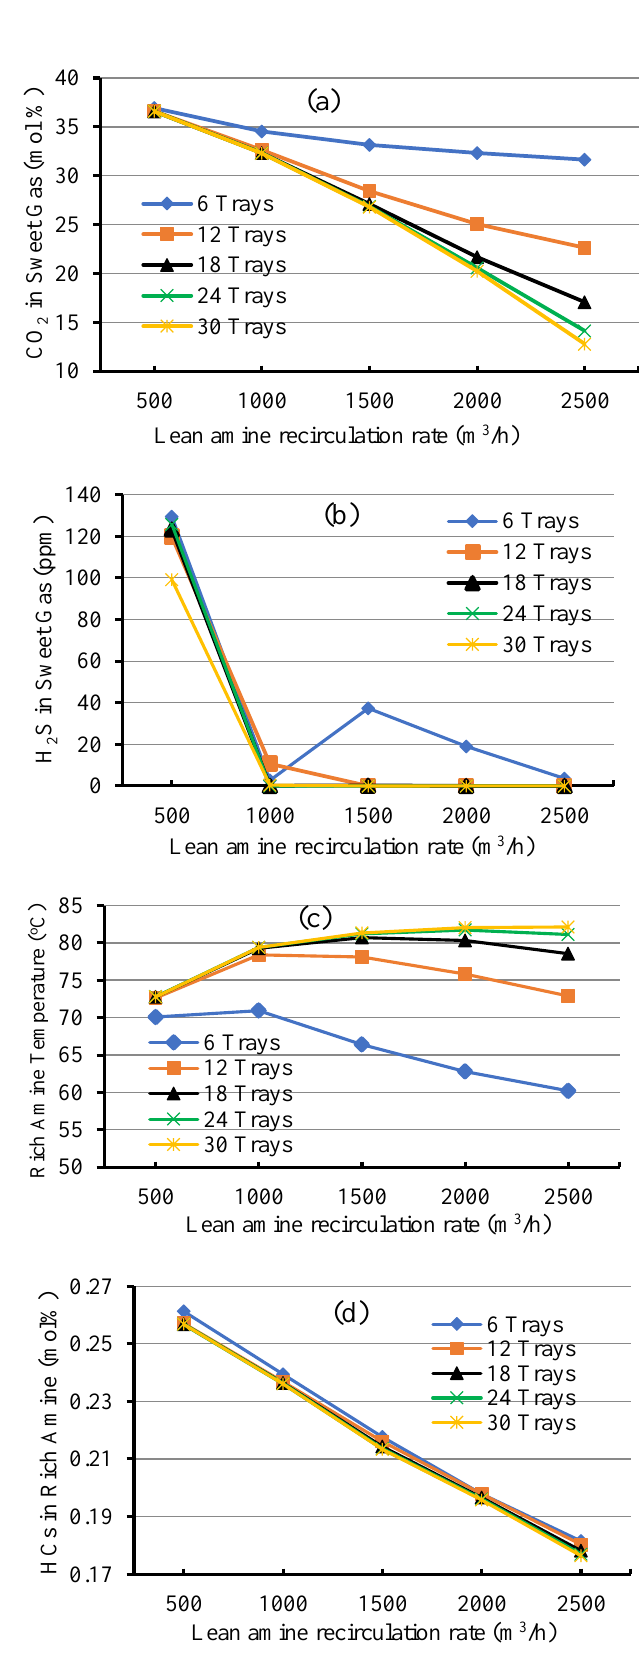
Fig. 3. Amine absorber performance with increasing recirculation rate and trays and 25 mol% MDEA in aqueous solution at pressure drop of 34